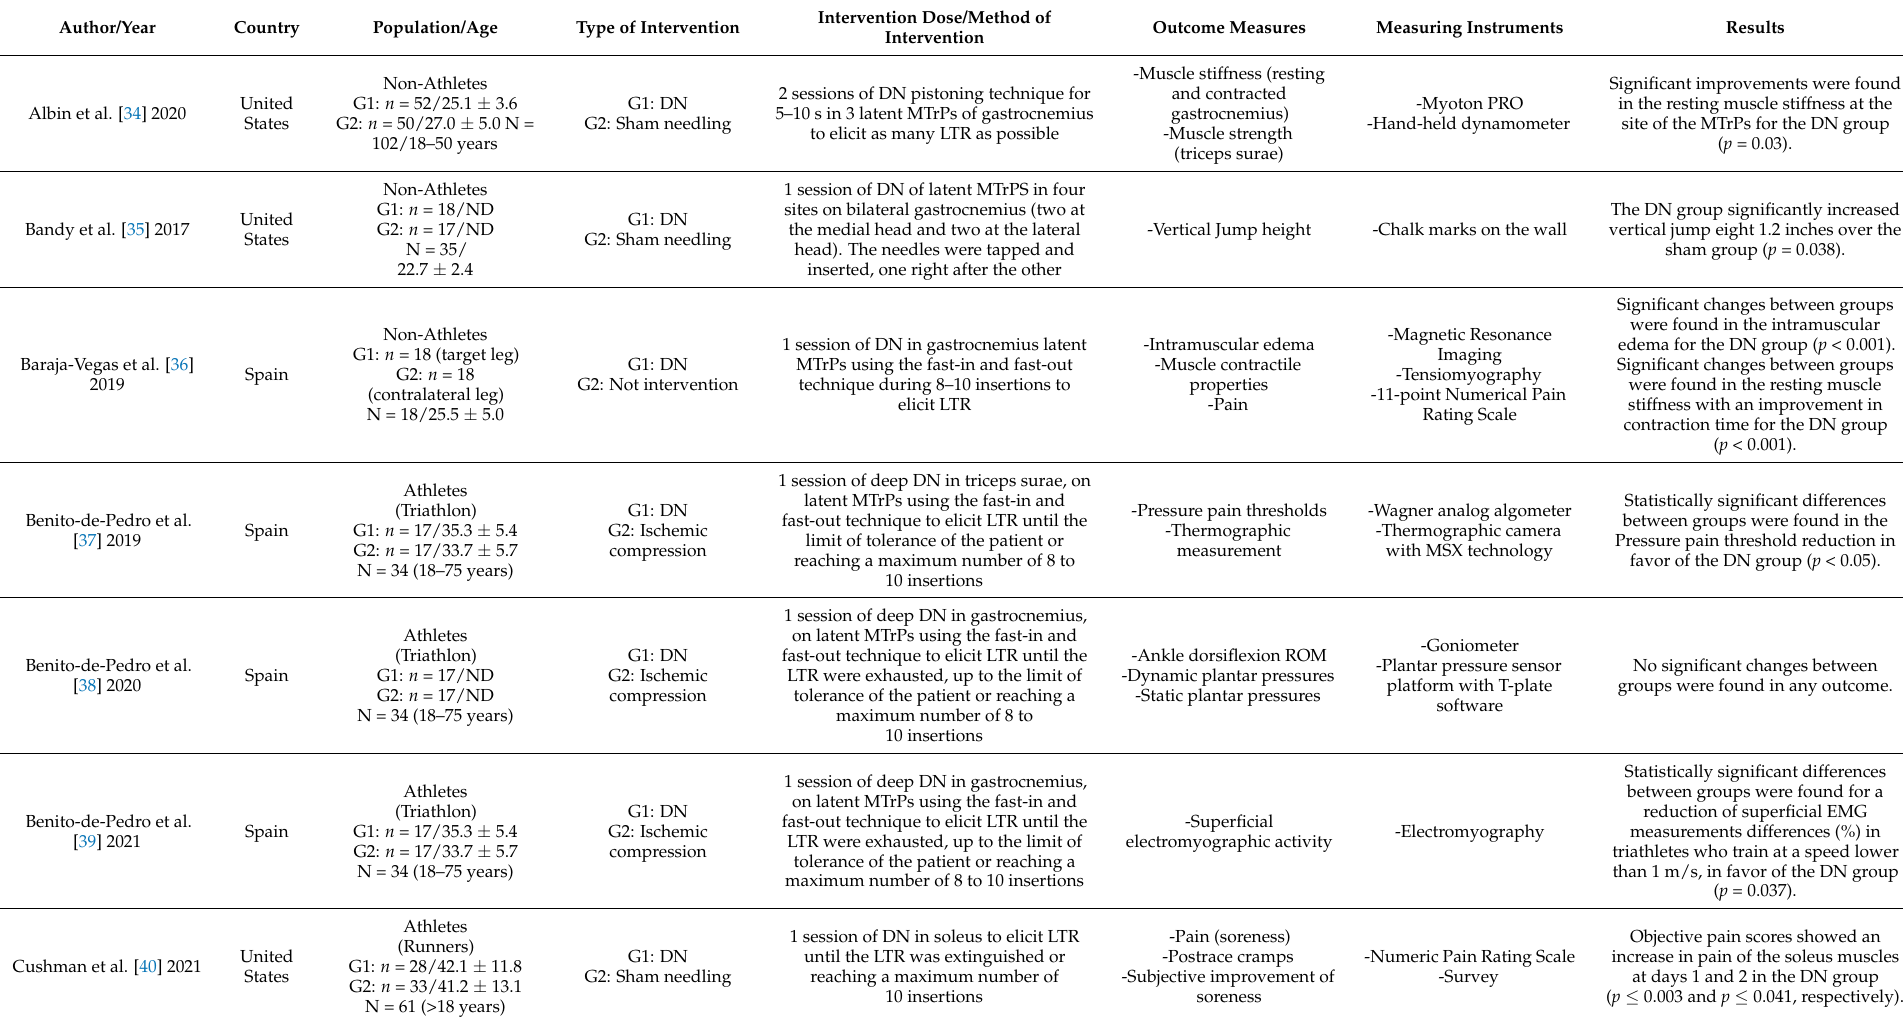
Table 1. Main characteristics of the studies included in the systematic